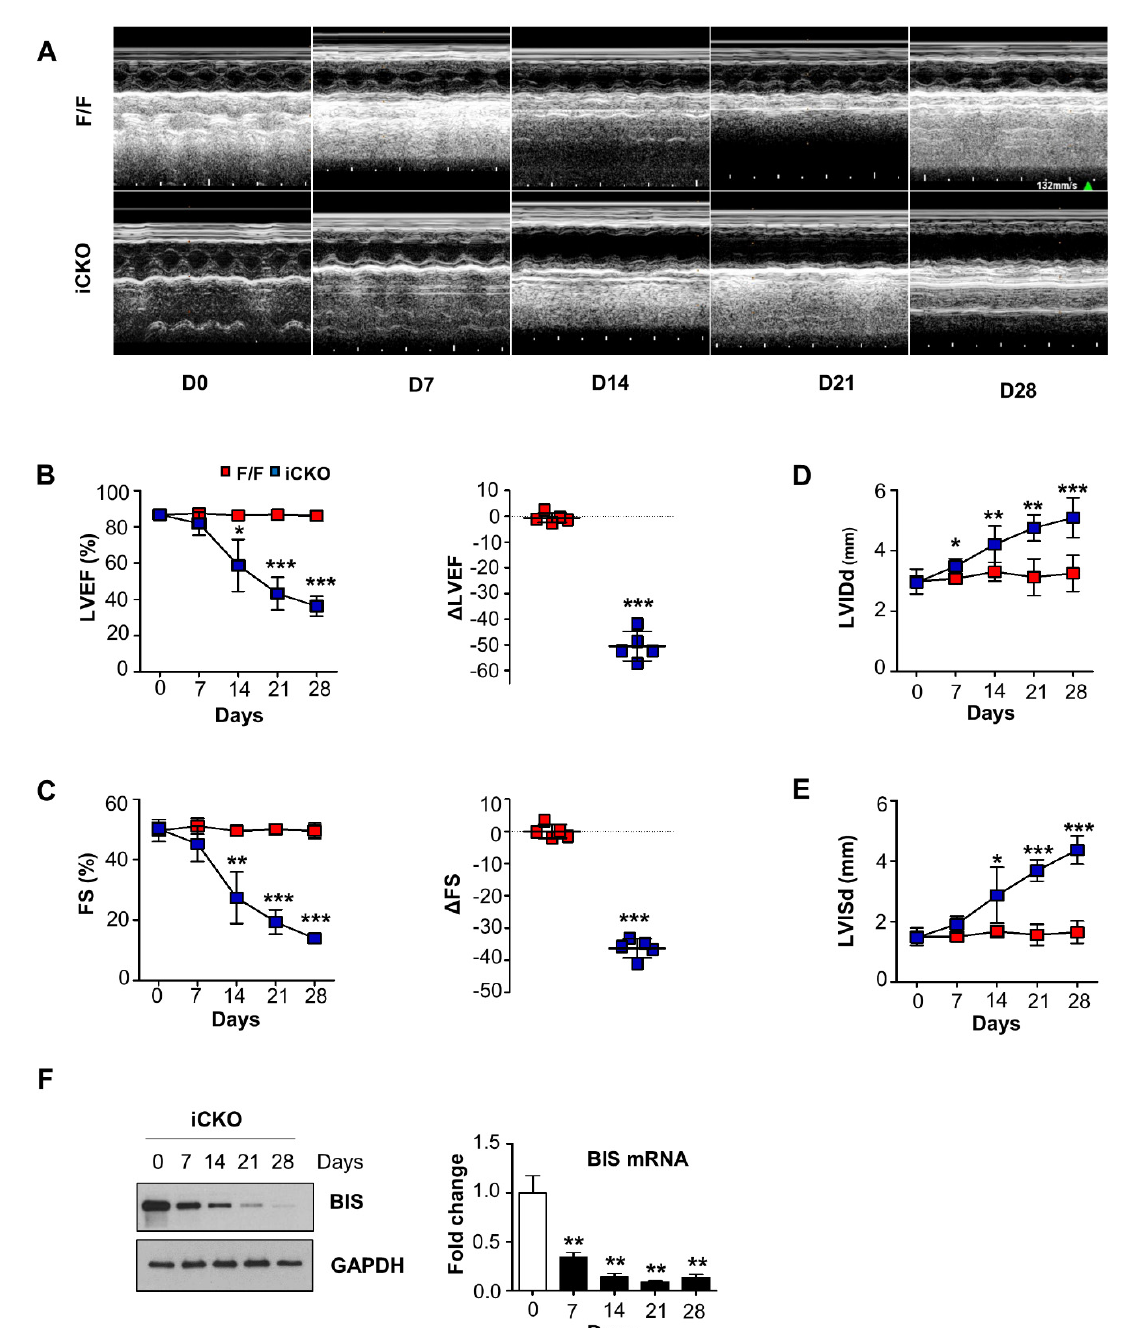
Figure 2. Tamoxifen-inducible depletion of BIS in the cardiomyocytes resulted in the development of dilated cardiomyopathy (DCM) in adult mice. ( A ) Echocardiographic tracing of F/F and iCKO mice before (D0) and after tamoxifen injection (D7, D14, D21 and D28). ( B , C ) Values of left ventricular ejection fraction (LVEF) and fractional shortening (FS) were obtained using echocardiography (left panels; n = 5 for both groups, 3 males and 2 females). LVEF delta and FS delta changes on day 28 are shown in the right panels. ( D , E ) Left ventricular internal diastolic dimension (LVIDd) and left ventricular internal systolic dimension (LVISd) were progressively increased in iCKO mice. Data are presented as the mean ± standard deviation (SD). * p < 0.05, ** p < 0.01, and *** p < 0.001 compared with the values from F/F mice on corresponding days. ( F ) Time-dependent BIS expression levels in iCKO mice after tamoxifen injection were determined using Western blotting assay (left) and qRT–PCR (right). ** p < 0.01 compared with the values on